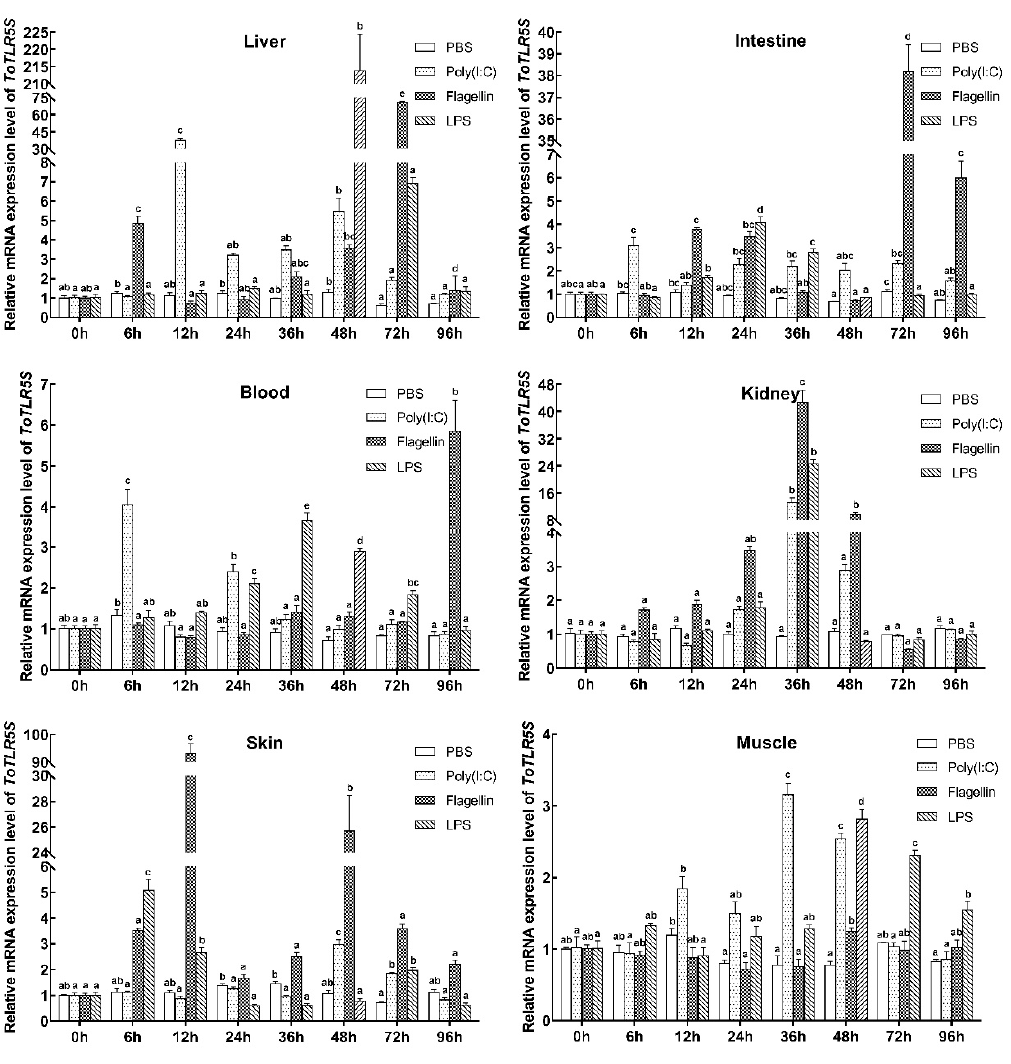
Figure 5. ToTLR5S expressions in different tissues (liver, kidney, intestine, skin, muscle, and blood) after PBS, flagellin, poly(I:C), and LPS challenge. EF-1 α acted as an internal control to calibrate the cDNA templates. All data are expressed as mean ± SE. Different letters show significant differences ( p < 0.05).